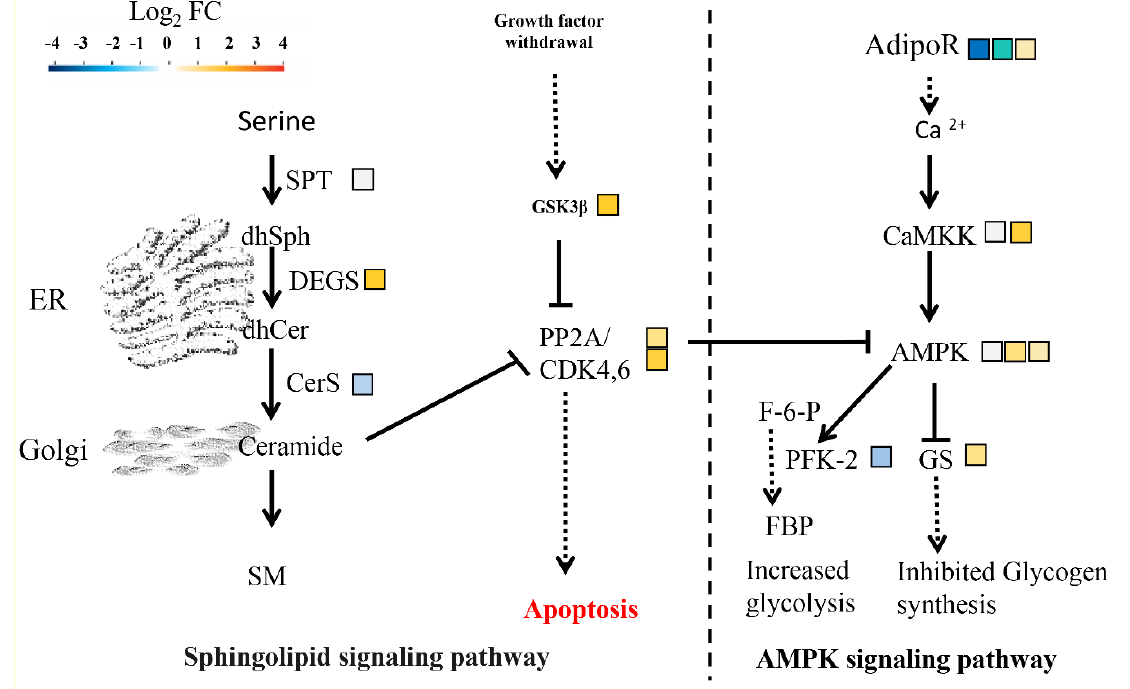
Figure 9. Signaling pathways were regulated by HSAF. The heat graphs indicate fold change of related genes according to the ratio with Log 2 FC. One square denotes one gene in related reaction and its color implies the gene’s expression level. The dotted arrows indicate uncertain pathways. The solid arrows indicate the known pathways. FC (Fold change of RPKM (HSAF)/RPKM (CK)), Sphingolipid signaling pathway: SPT : serine palmitoyltransferase, CerS : ceramide synthase, DEGS : sphingolipid 4-desaturase/C4-monooxygenase, PP2A : protein phosphatase 2A, GSK3 β : glycogen synthase kinase 3 beta, BCL-2 : apoptosis regulator. AMPK signaling pathway: CaMKK : calcium/calmodulin dependent receptor, PFK-2 : fructose-2, 6-biphosphatase